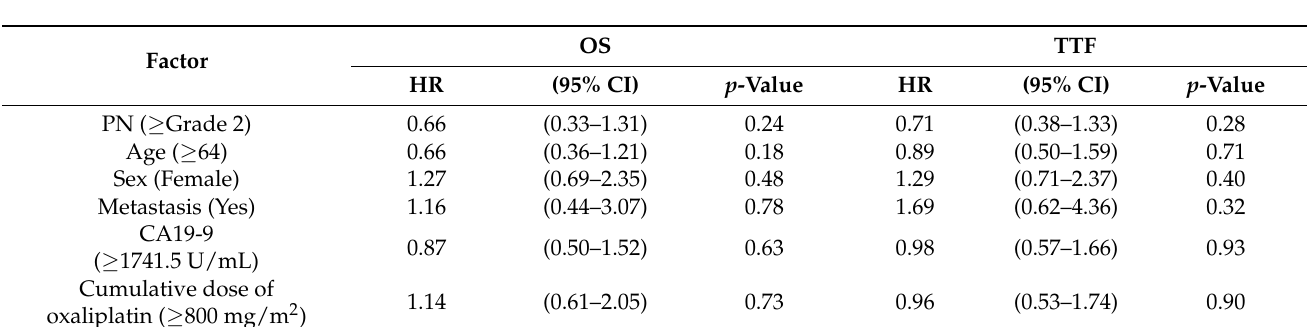
Table 3. Cox proportional hazards analyses of OS and TTF in unresectable APC patients receiving